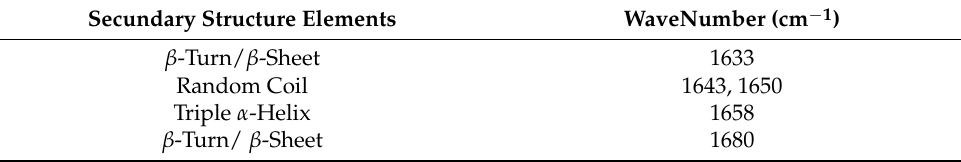
Table 6. Assignments to secondary structure ( β ‐ sheet, triple α ‐ helix) for salmon gelatin.